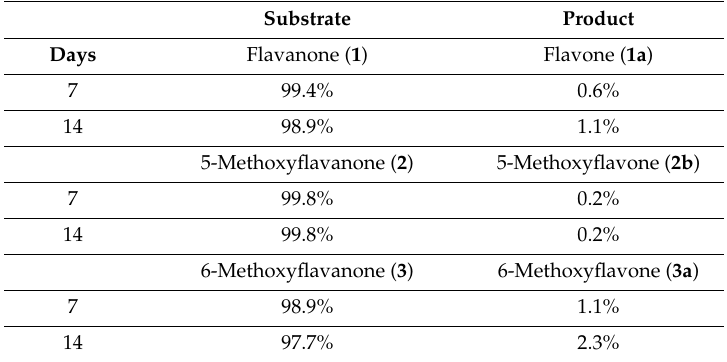
Table 1. Percentage of substrates and biotransformation products in P. coccineus water cultures.